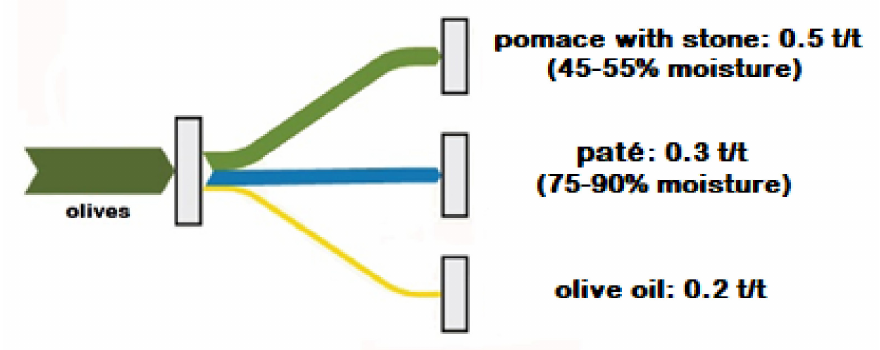
Figure 7. Schematic representation of the MPD with relative material